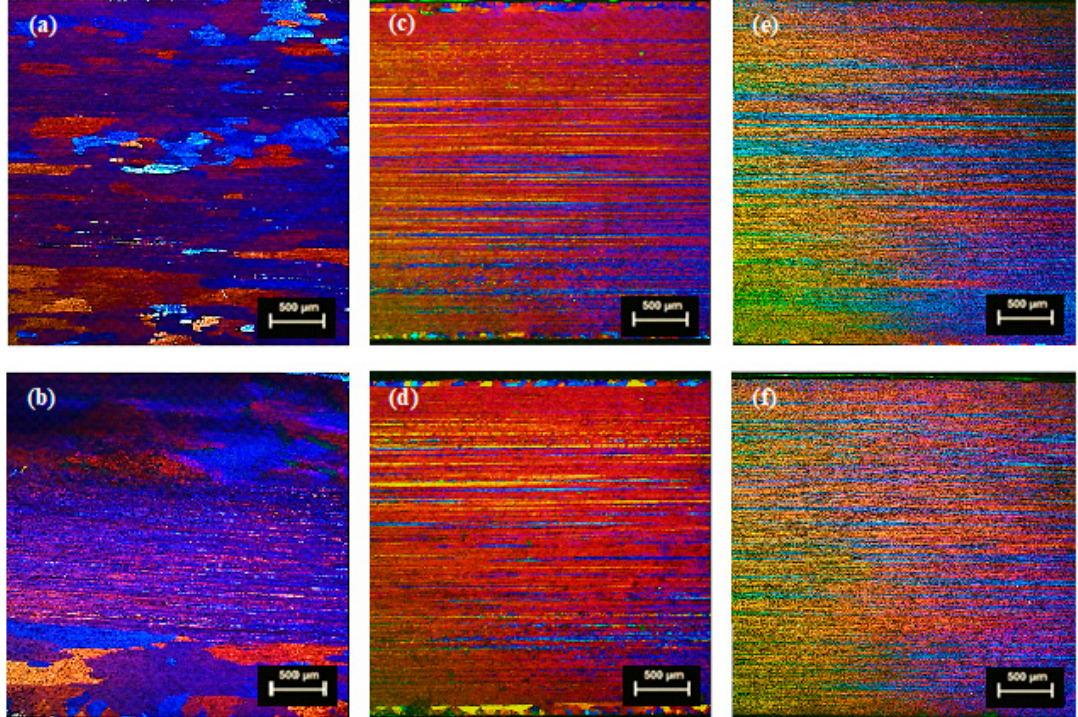
Figure 5. Optical micrographs of extruded planks in longitudinal direction; ( a , b ) formulated TT-6111 (1) extruded from homogenized billets; ( c , d ) formulated TT-6111 (2) with recrystallization inhibitors and extruded from homogenized billets; ( e , f ) formulated TT-6111 (3) with recrystallization inhibitors and extruded from non-homogenized billets. Where ( a , c , e ) DC-GR casting; and ( b , d , f ) MC-DC casting.